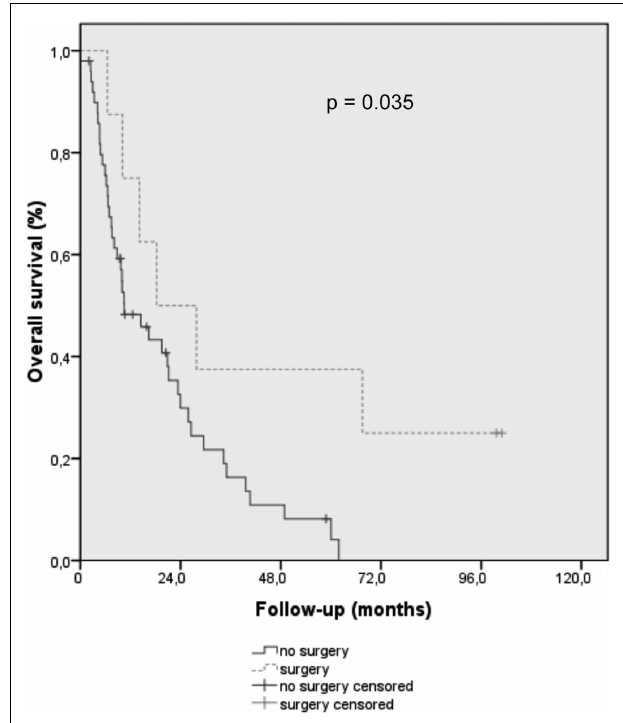
FIGURE 2 | Overall survival curve using Kaplan–Meier methods for elderly patients treated for esophageal and gastroesophageal cancer, with surgery (dotted line) or without (full line) .